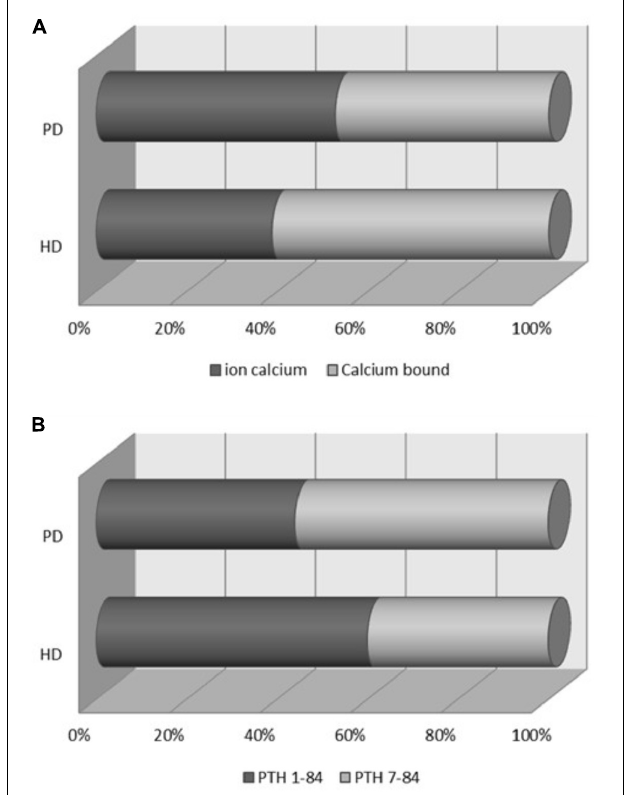
FIGURE 1 | (A) Distribution of calcium ion and calcium bound expressed as percentage of total calcium. iCa accounted for 39% of tCa in the HD group and for 53% of tCa in PD patients, P < 0.001. (B) Distribution of circulating PTH fragments (1-84 PTH and non- 1-84 PTH) expressed as percentage of intact PTH (1-84 PTH plus non-1-84 PTH). Percentage of 1-84 PTH in PD patients (44.0 ± 12.28%) vs. HD patients (60.3 ± 10.82%), p < 0.001. HD, hemodialysis; PD, peritoneal